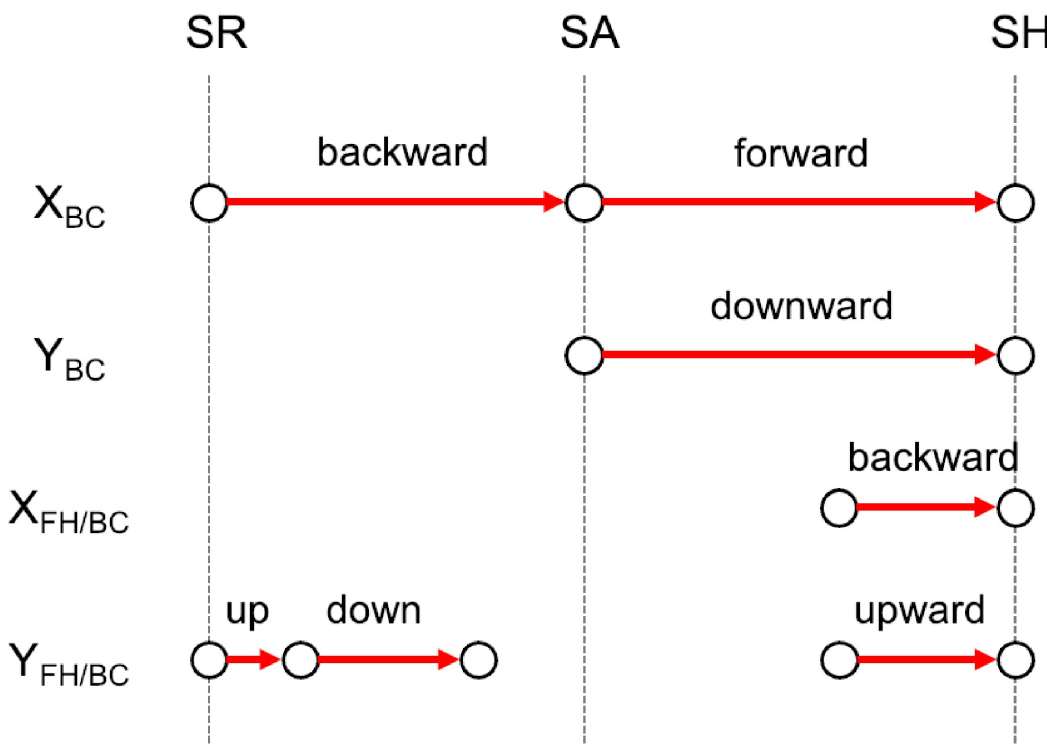
Fig 25. Motion scheme of Steffen’s body center and free hand. The protective gesture during the retreat is represented by arrows for the body center backward and the free hand up/down. The balancing gesture during the lunge attack is represented by arrows for the body center forward/downward and the free hand